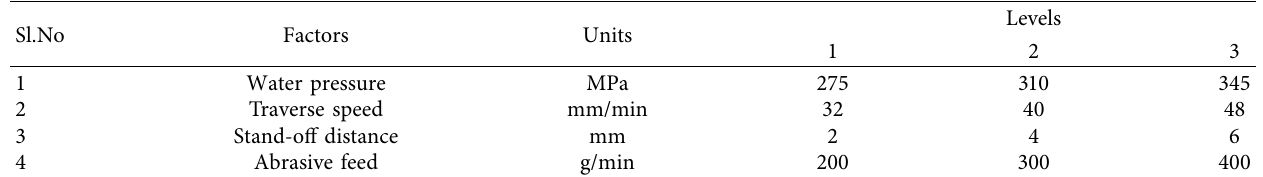
Table 2: Abrasive water jet cutting factors and levels for DoE.